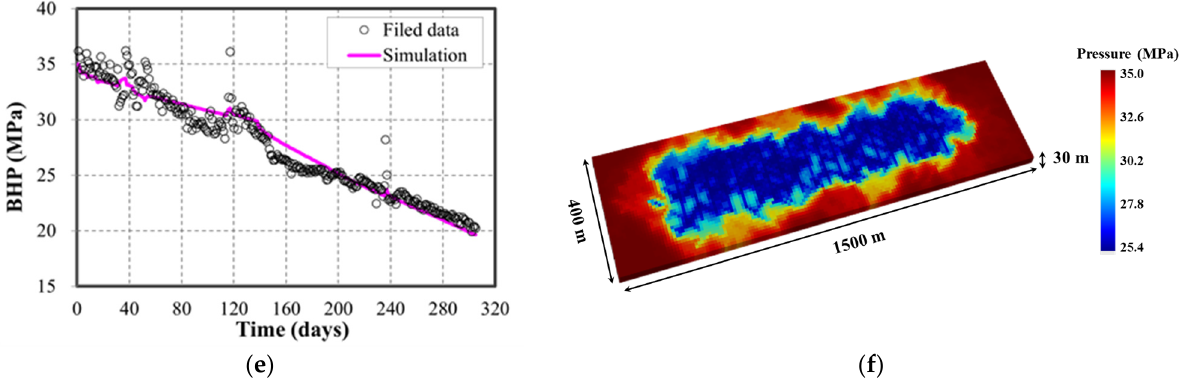
Figure 11. Comparison of model simulation and field data: ( a ) gas flow rate; ( b ) cumulative gas production; ( c ) water flow rate; ( d ) cumulative water production; ( e ) bottom hole pressure; ( f ) pressure distribution after 305 days of production.